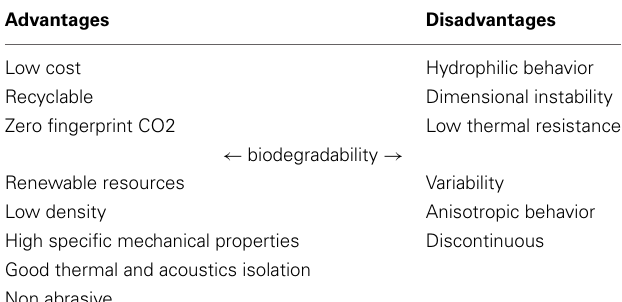
Table 2 | Advantages and drawbacks of plant